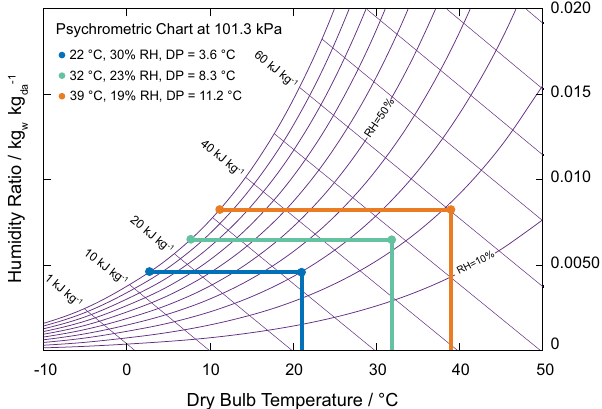
Fig. 2 | The effect of RH and temperature on dew point when using MOF-801. The condensation compartment response for the desorption phase of a WHC shown on a psychrometric chart at a starting point whose environmental condi- tions were 30% RH and 22°C (blue). Optimizing the heating for 10 (green) and 20min (orange) increases the dew point by 4.7 and 7.6°C, respectively. This increaseindewpointhasalargeimpactoncondenserpowerconsumption.Source data are provided as a Source Data fi